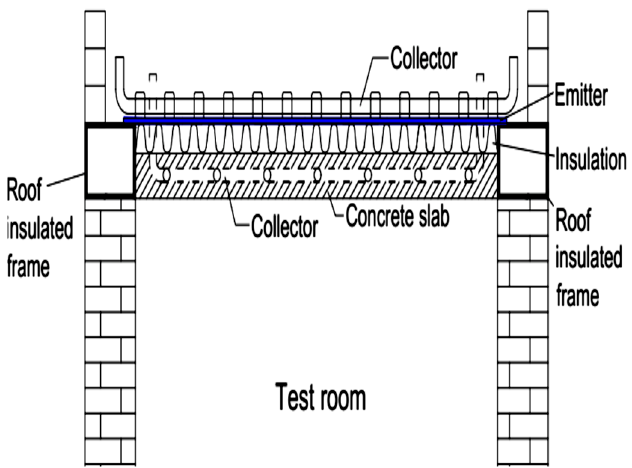
Figure 29. Suggested honeycomb-shaped open-cell insulation for the roof’s insulation [5].